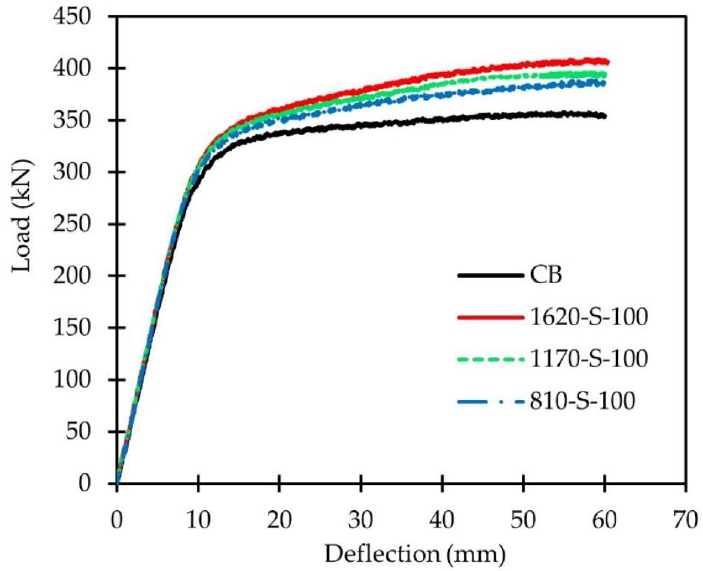
Figure 13. Load – deflection curves of 1620-S-100, 1170-S-100, 810-S-100 and CB. Figure 13. Load–deflection curves of 1620-S-100, 1170-S-100, 810-S-100 and CB.